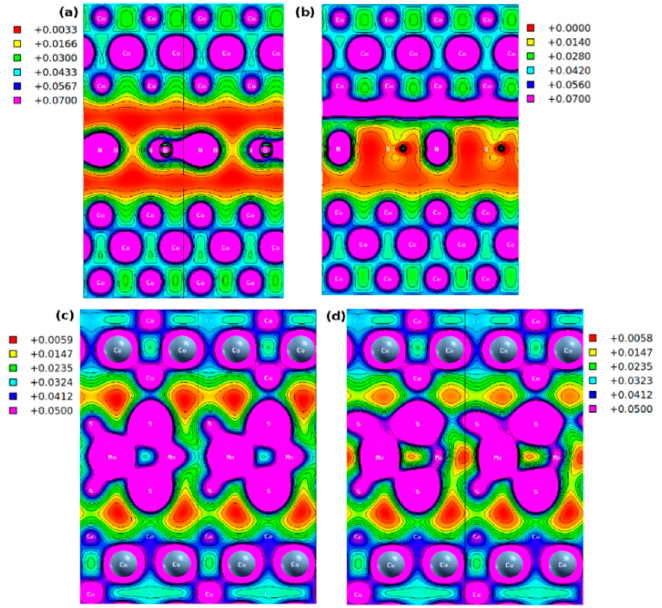
Figure 7. Contour plots of the total (volumetric) charge density distribution in the [110] plane at 0.0 ( a ) and 0.1 a.u. ( b ) electric field. The top panels denote Co(111)/hBN/Co(111) while the bottom panels denote Co(111)/MoS 2 /Co(111) at 0.0 a.u. ( c ) and 0.1 a.u. ( d ).